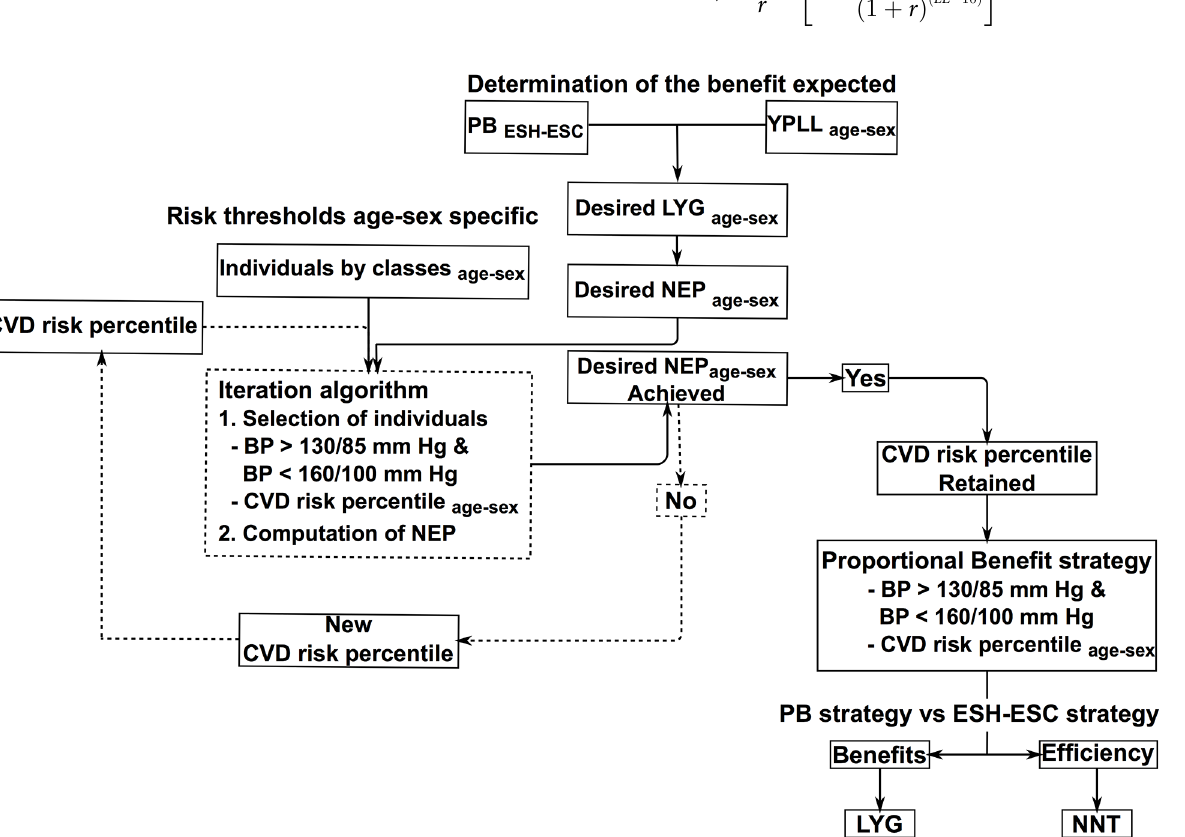
Fig 2. Simulation steps to design the proportional benefit strategy to identify the treatment target population. The reference is the overall Proportional Benefit, i.e. the relative life-year gain obtained from the application of the 2007 ESH/ESC recommendation on the potentially eligible individuals from the Realistic Virtual French Population. Abbreviations: PB, proportional benefit; YPLL, years of potential life lost; LYG, life-years gained; NEP, number of events prevented; NNT, number needed to treat to gain a life-year.